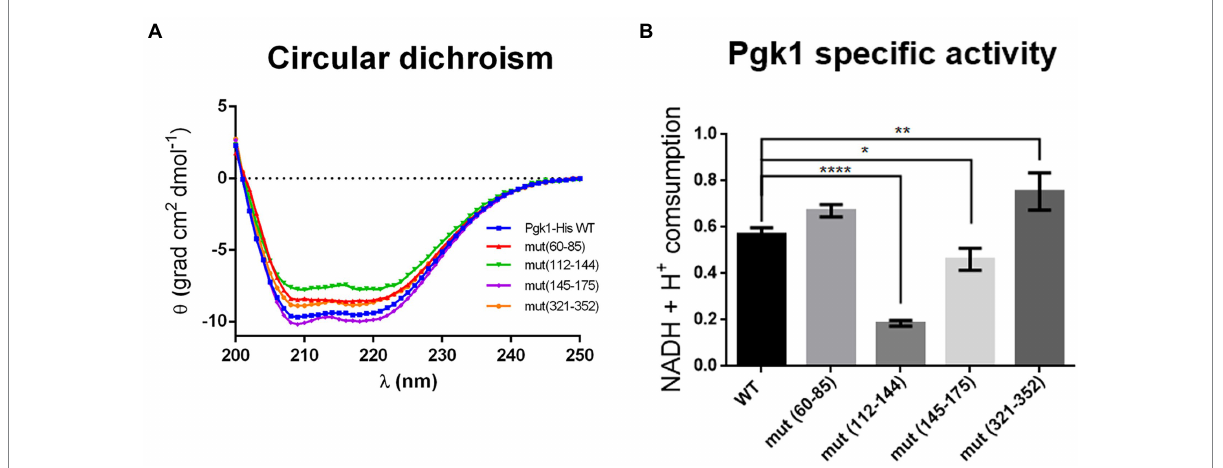
FIGURE 3 Pgk1 folding and activity are slightly altered by synonymous mutations in pgk1 . (A) Circular dichroism of the purified Pgk1 from WT and mutant strains. (B) Pgk1 specific activity assayed with 5 nM purified Pgk1 (WT and mutants), in an assay coupled to GAPDH. The results are representative of three independent assays. Data was analyzed by one-way ANOVA (* p < 0.05; ** p < 0.02; **** p <